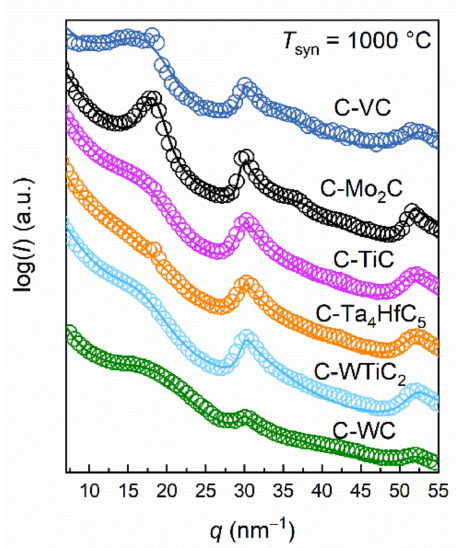
Figure 1. Wide-angle X-ray scattering data (spheres) of different carbide-derived carbons (CDCs, noted in Figure) and fit curve (solid line), where the scattering vector modulus, q , is defined as q = 4 π sin( θ )/ λ , where 2 θ is the scattering